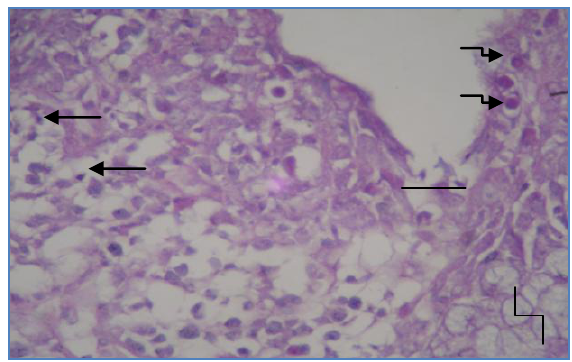
Figure, 5: Control trachea shows normal tissue, 72 hrs. post infection (H and E) (100X).